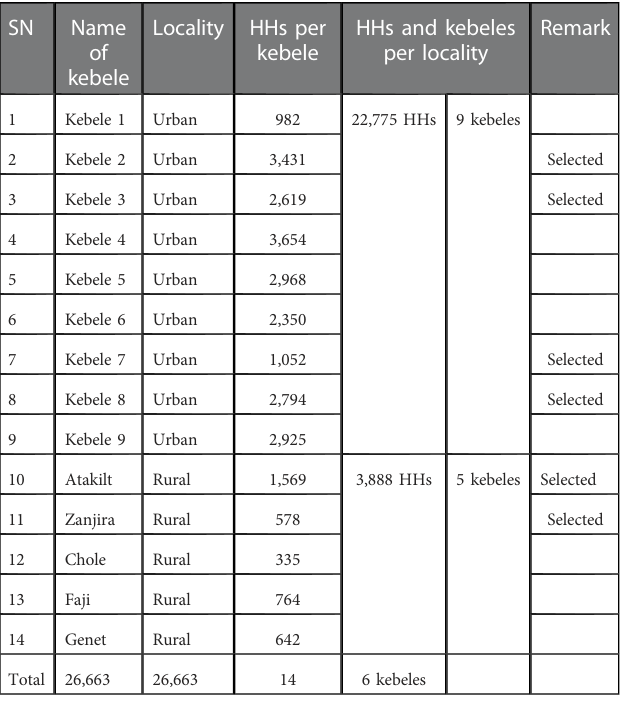
TABLE 1 Number of households in each of the kebeles of Debre Berhan, 2021